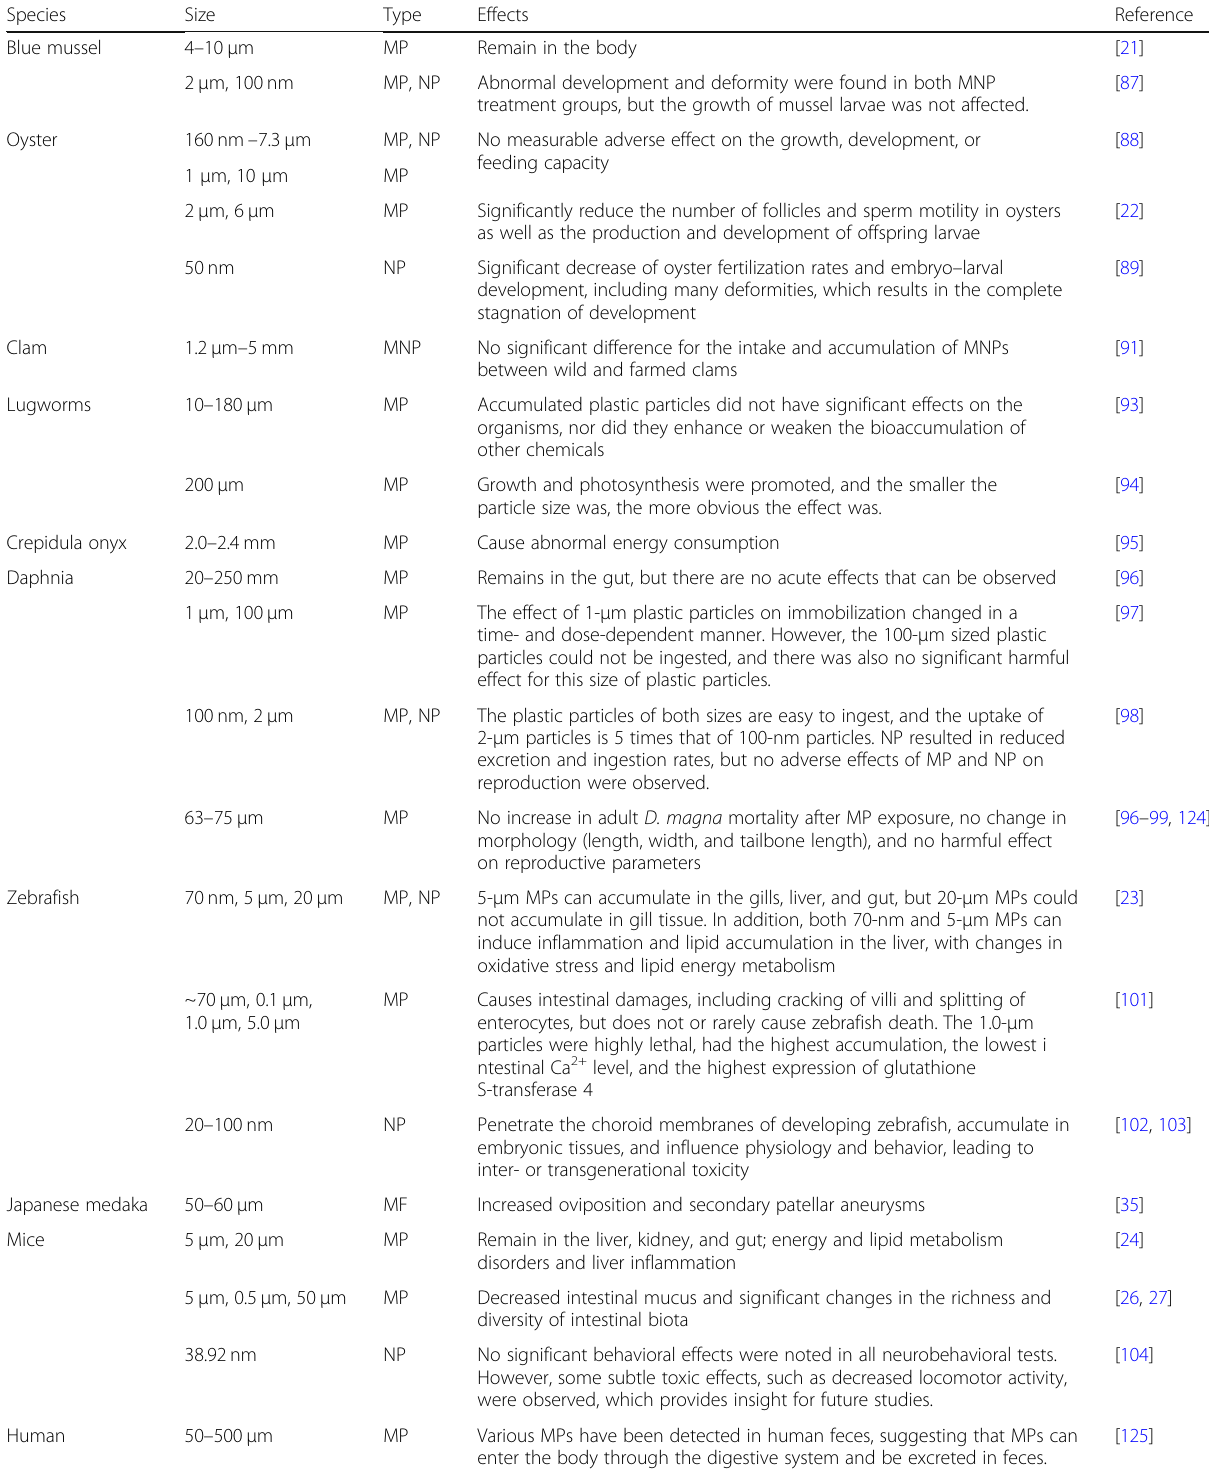
Table 2 A summary of the health impacts of MNPs reviewed in our study